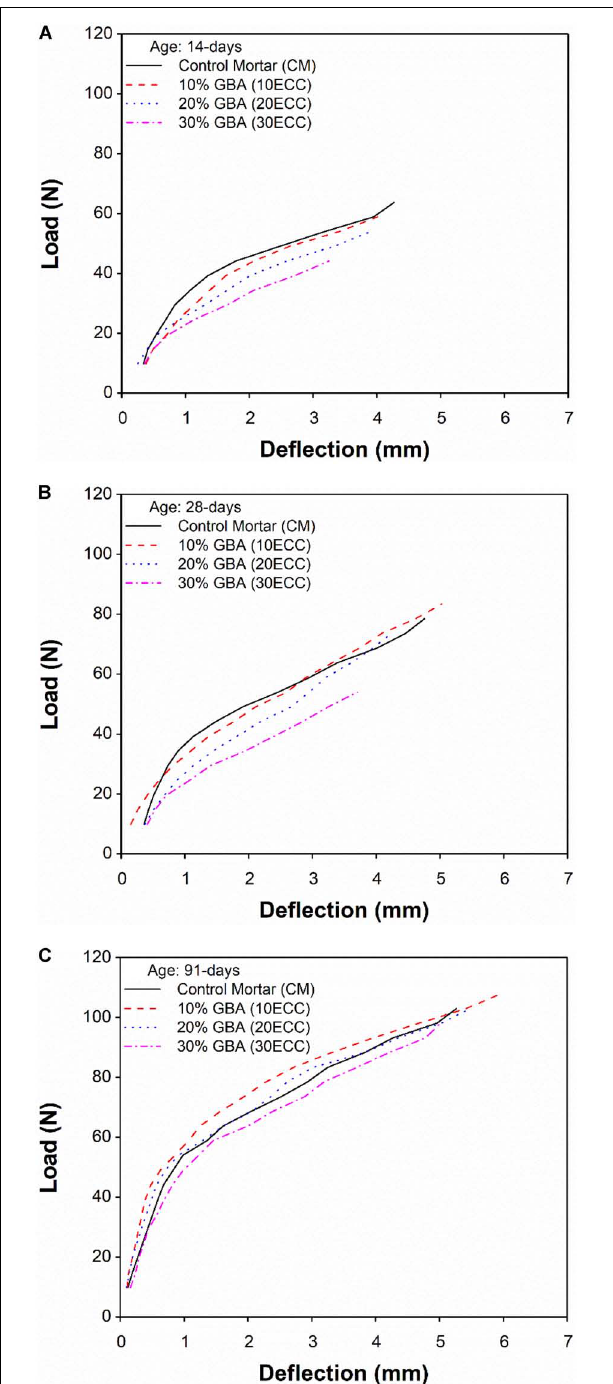
FIGURE 11 | Comparison of the load-deflection behavior among the CM and ECC mixes at an age of: (A) 14, (B) 28, and (C) 91 days.